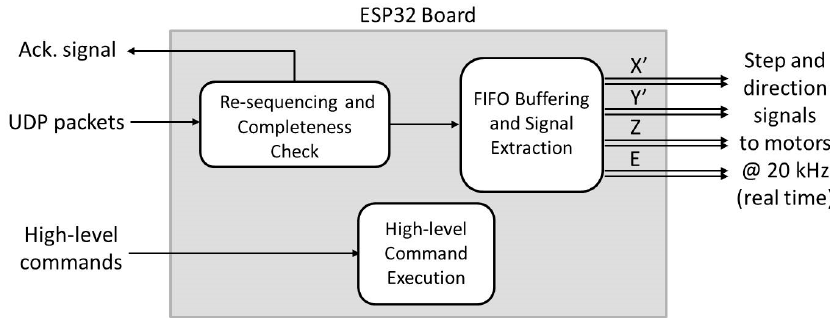
Figure 4. Block diagram of functionalities coded as firmware into the ESP32 board.